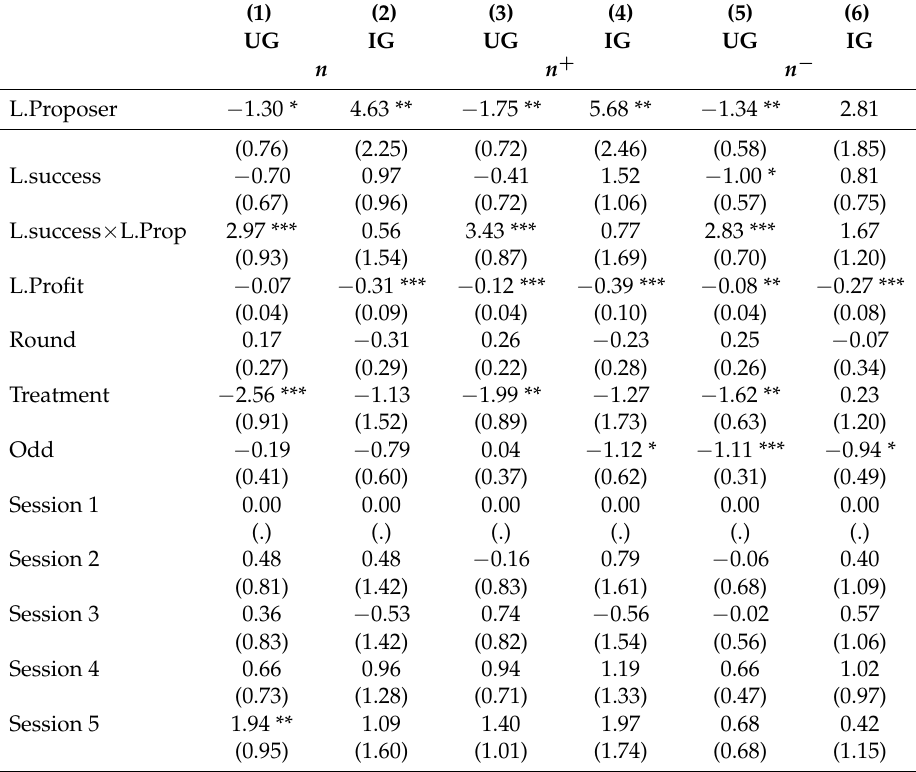
Table A2. Choice dynamic by Game (2)-controlling for single